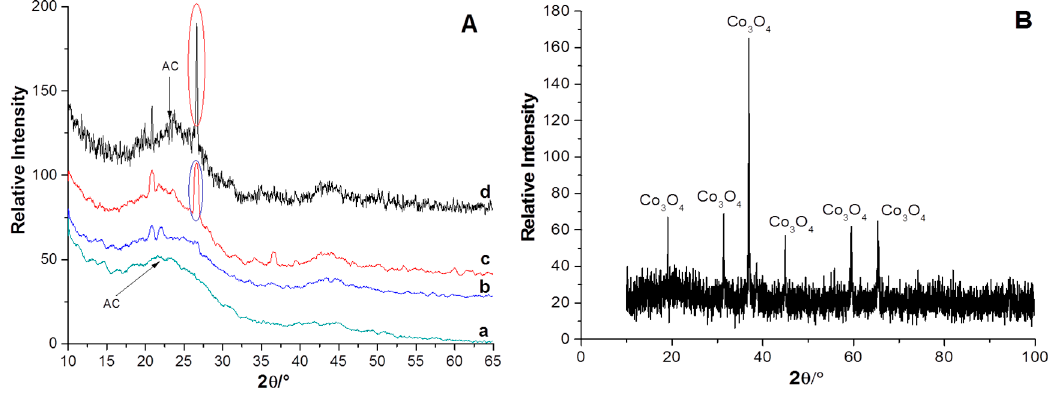
Figure 1. XRD of ( A ) supports: ( a ) RB3, ( b ) RX3, ( c ) G60 and ( d ) CNR; and ( B ) Co 3 O 4 /G60 catalyst.